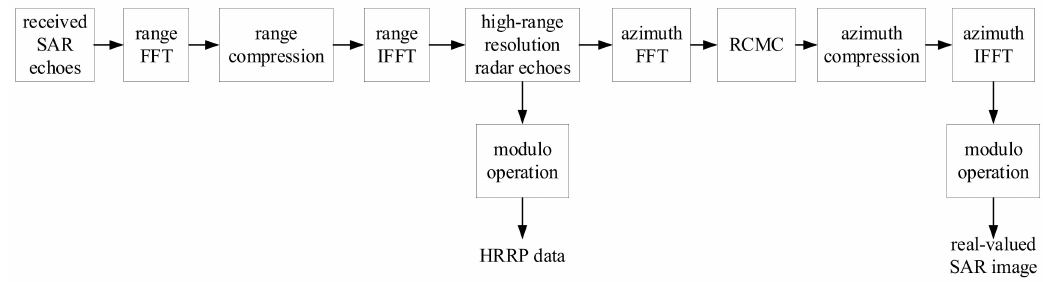
Figure 1. The data acquisition of HRRP data and real-valued SAR images from received SAR